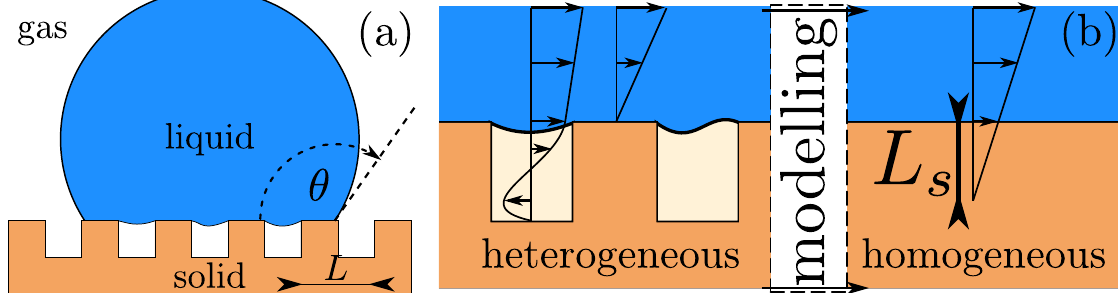
Figure 2. ( a ) Sketch of a water drop onto a textured superhydrophobic surface. ( b ) Close up of the surface region in a channel flow with superhydrophobic surfaces, depicting the near-wall, capillary-driven microscopic free-surface dynamics, as well as its modeling using a slip condition with slip length L s